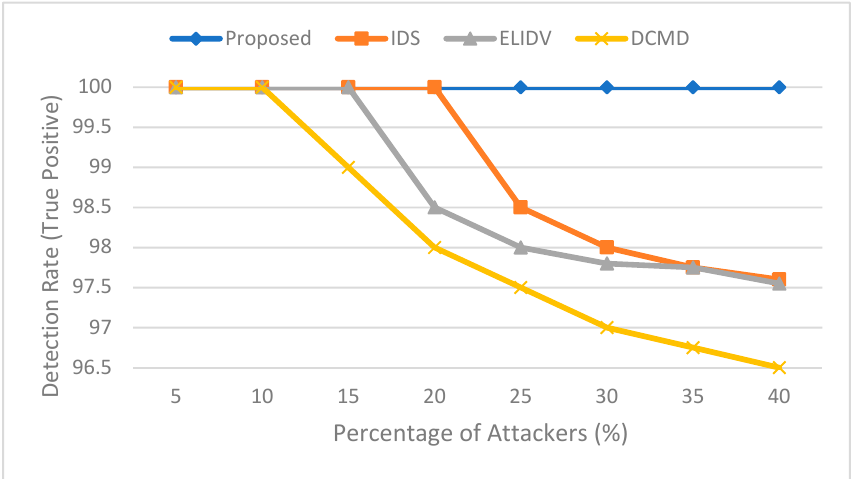
Figure 5. Detection rate comparison in case of false information attack.